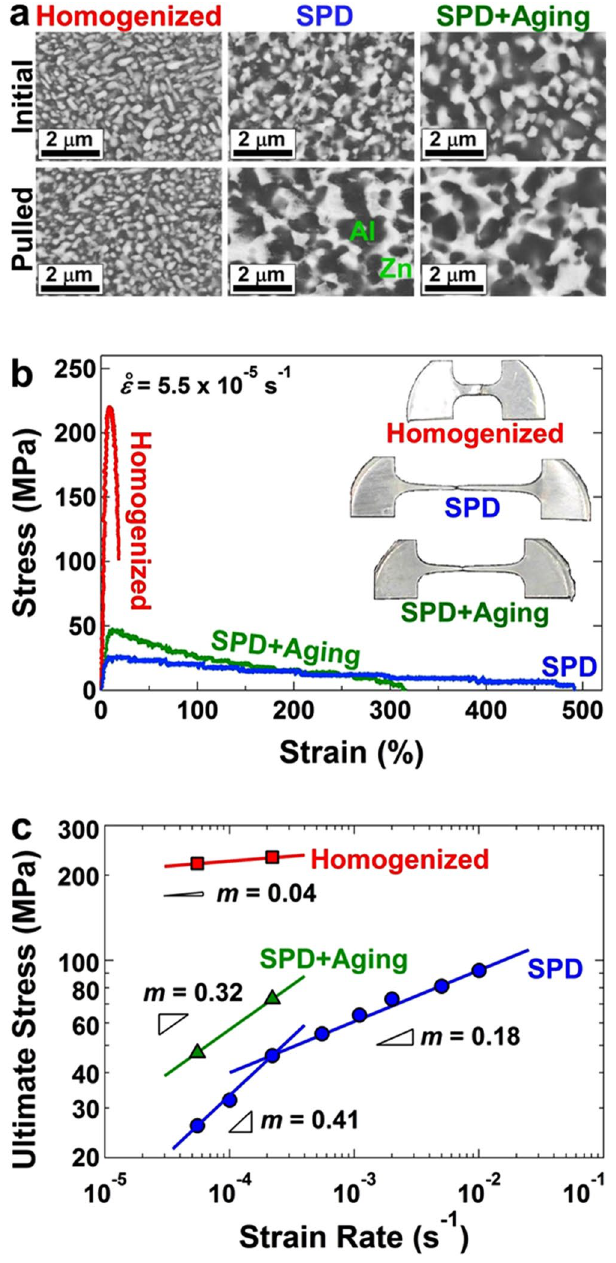
Figure 1. Room-temperature superplasticity with a maximum elongation of 480% and a strain-rate sensitivity of 0.41 is achieved after SPD processing. Microstructure and tensile properties of Al-Zn alloy processed with homogenization, SPD and SPD followed by natural aging for 100 days. ( a ) SEM-BSE images showing the size and distribution of Al- and Zn-rich phases before and after tensile test. ( b ) Stress-strain curves obtained under tension with a strain rate of 5.5 × 10 − 5 s − 1 . Inset: appearance of tensile specimens after pulling to failure. ( c ) Ultimate tensile stress plotted versus strain rate in double logarithmic scale; the slopes show the strain-rate